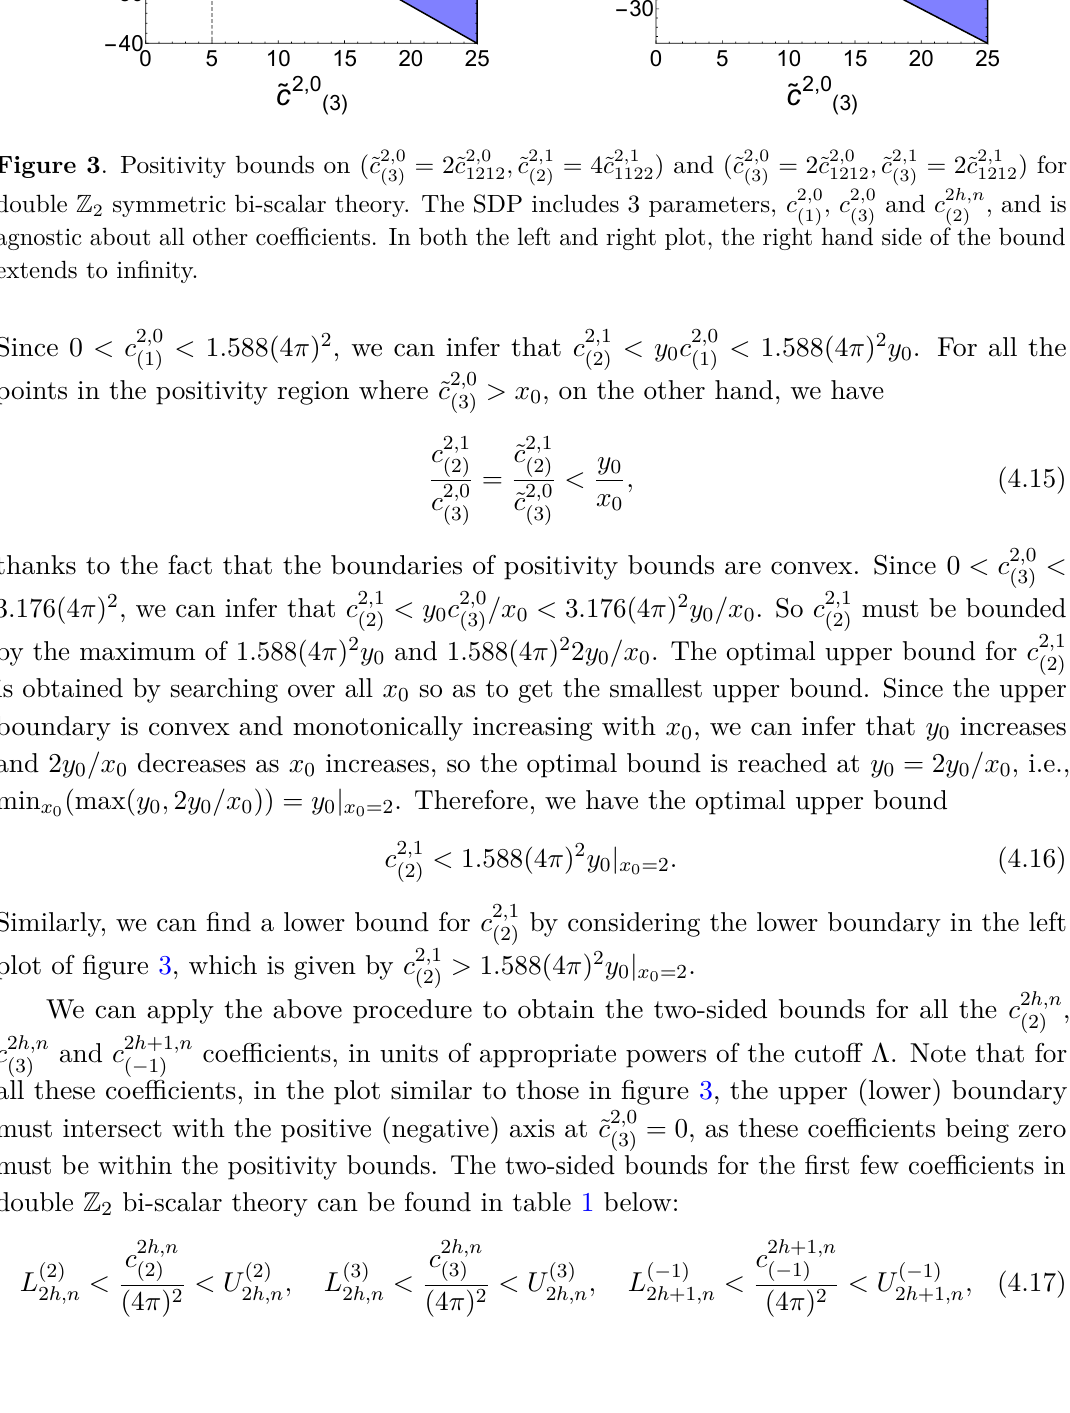
= 2˜ c 2 , 0 = 4˜ c 2 , 1 ) and (˜ c 2 , 0 = 2˜ c 2 , 0 = 2˜ c 2 , 1 ) for , ˜ c 2 , 1 , ˜ c 2 , 1 1212 1122 1212 1212 (3) (2) (3) (3) , c 2 , 0 and c 2 h,n , and is (1) (3) (2)